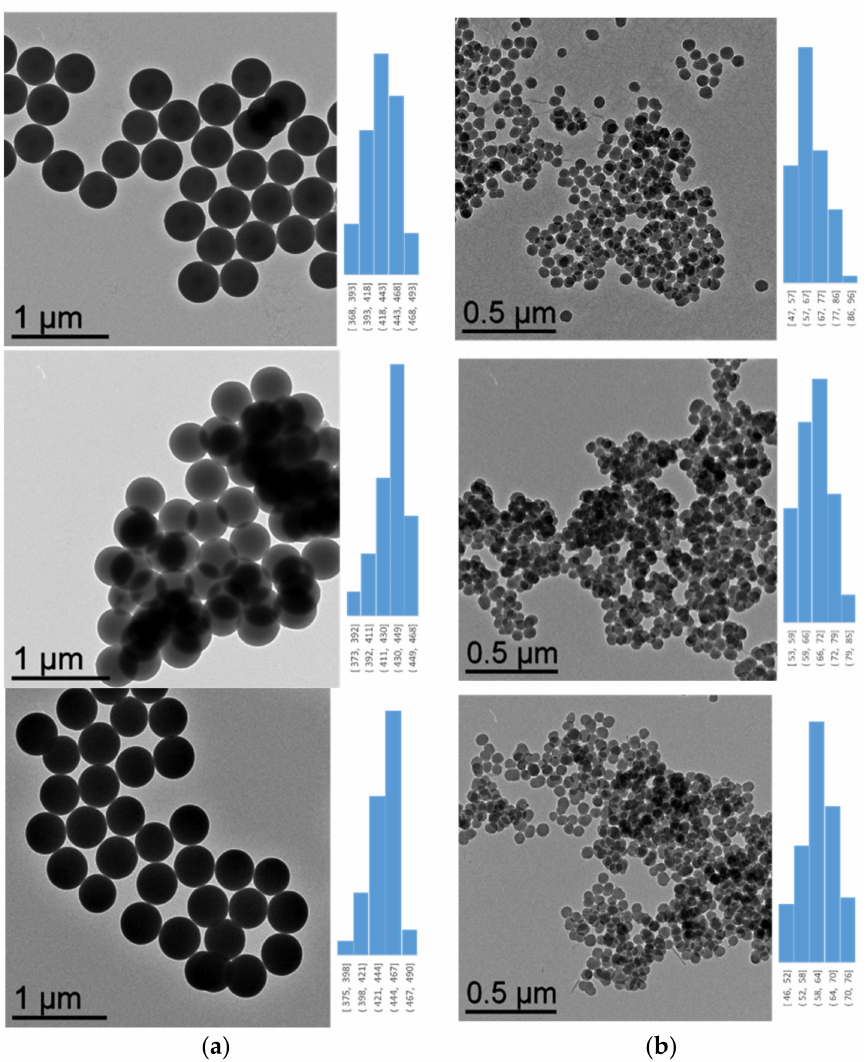
Figure 5. From top to bottom: TEM images and diameter distribution of SiO 2 , SiO 2 @CN , SiO 2 @COOH beads from SiO 2 beads produced in EtOH ( a ) and MeOH ( b